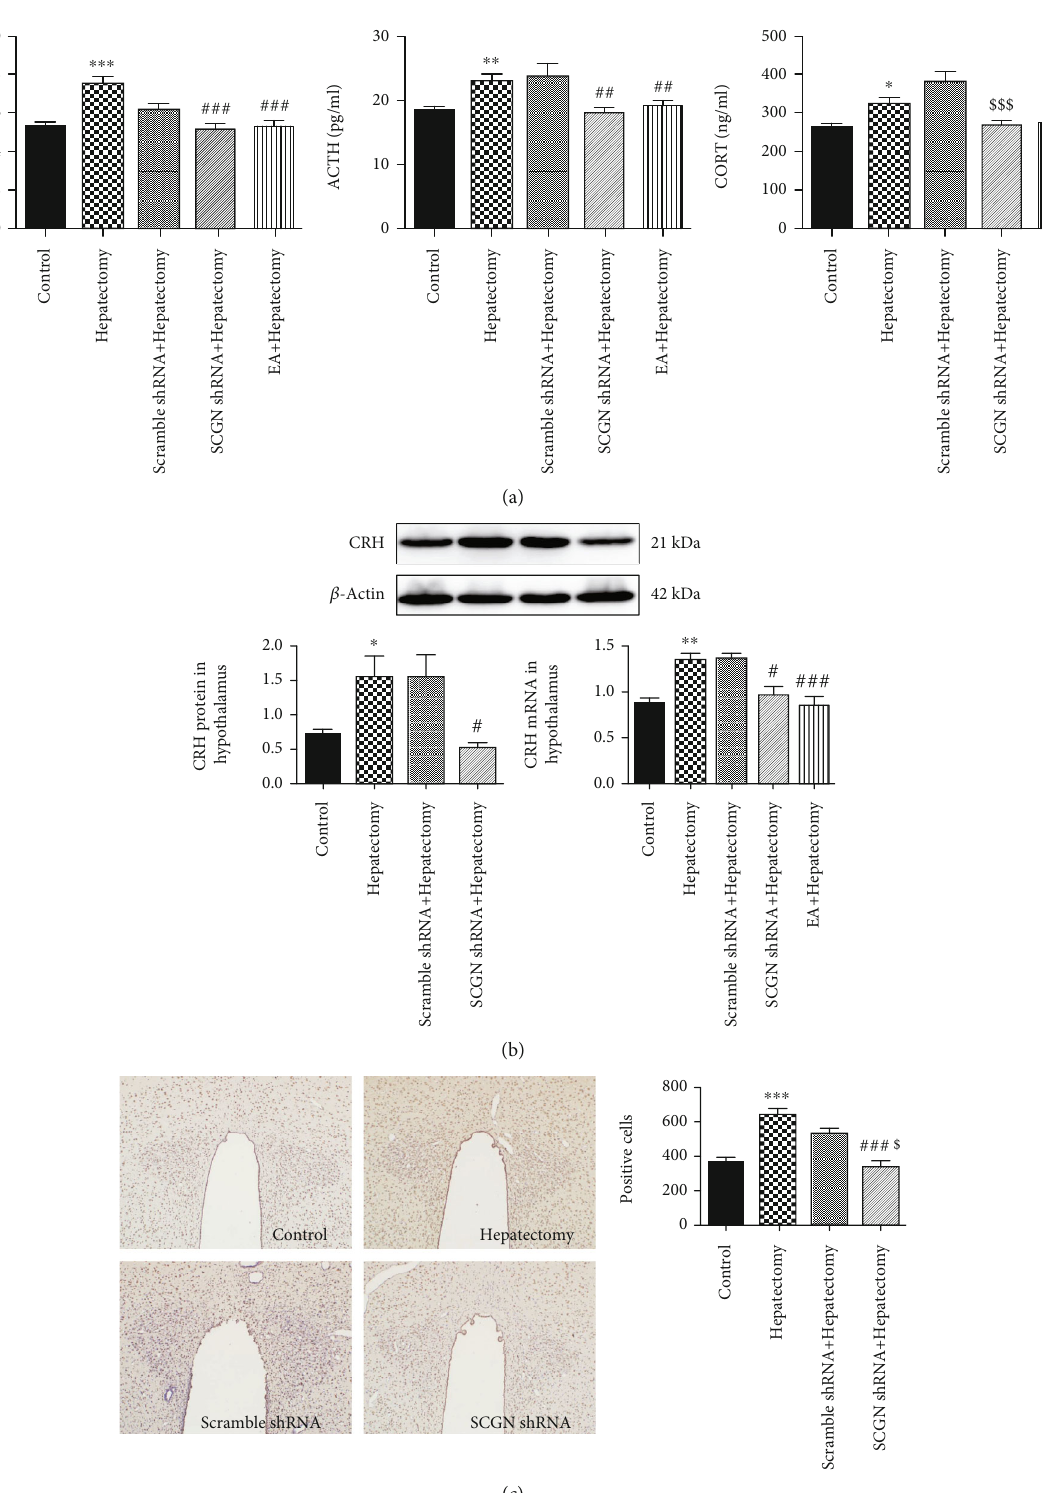
Figure 4: (a) Peripheral serum CRH, ACTH, and CORT levels were detected by the radioimmunoassay after rats su ff ering surgical trauma. (b) Representative bands and quanti fi cation of CRH protein level and CRH mRNA expression. (c) CRH-positive cells and quanti fi cation in the control, hepatectomy, scramble shRNA+hepatectomy, and SCGN shRNA+hepatectomy at 24 h after hepatectomy. Data are represented as the mean ± SEM ( n = 6 ). ∗ vs. control group ( p < 0 : 05 ): ∗∗ p < 0 : 01 , ∗∗∗ p < 0 : 001 ; # vs. hepatectomy group ( p < 0 : 05 ): ## p < 0 : 01 , ### p < 0 : 001 ; $ vs. scramble shRNA+hepatectomy group ( p < 0 : 05 ): $$ p < 0 : 01 , $$$ p < 0 : 001